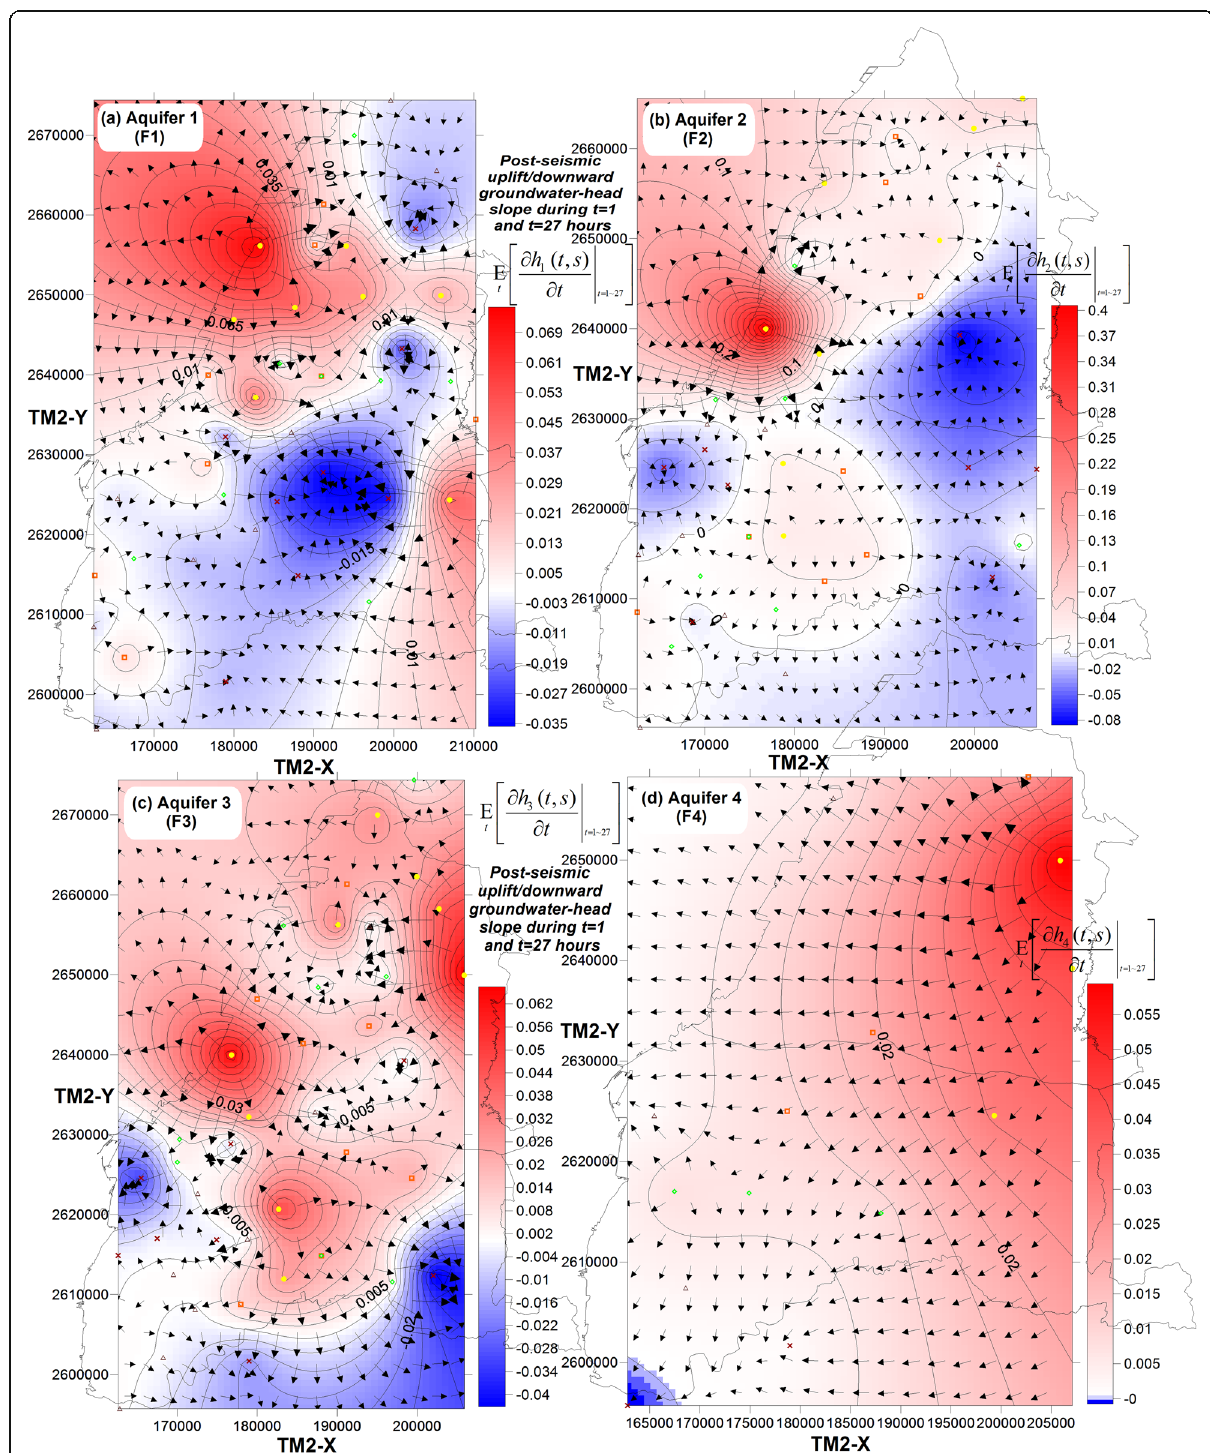
Fig. 9 The investigated pattern of post-seismic uplift/downward partial derivatives of groundwater head vs. time during t = 1 and t = 27 across multiple